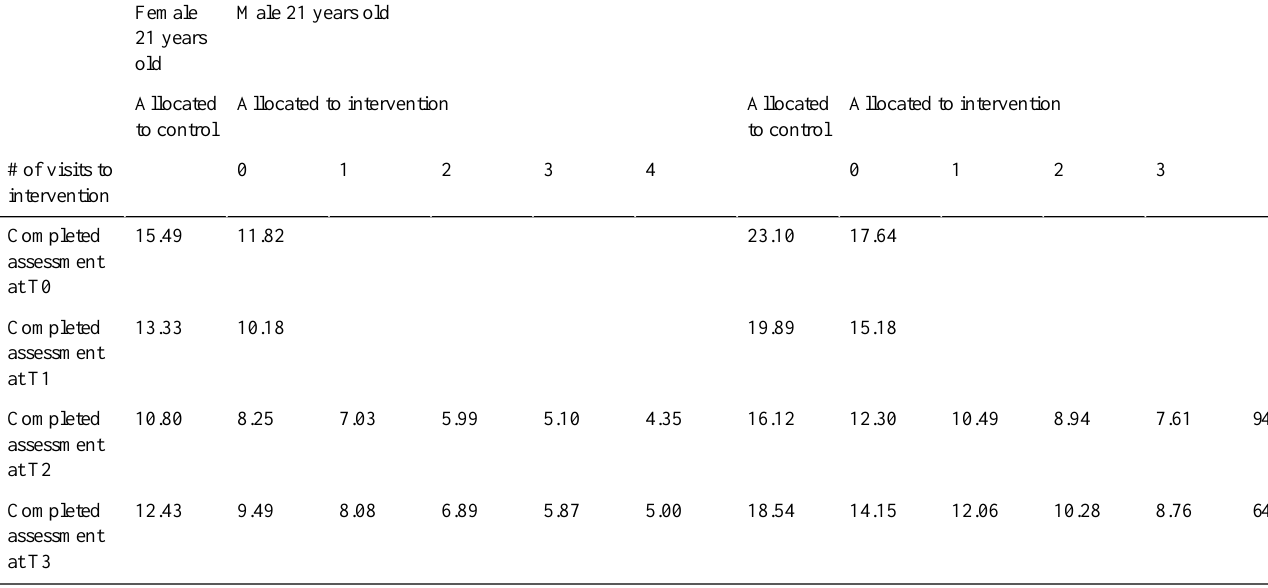
Table 4. Prediction of units consumed over the last week at each time point (longitudinal regression